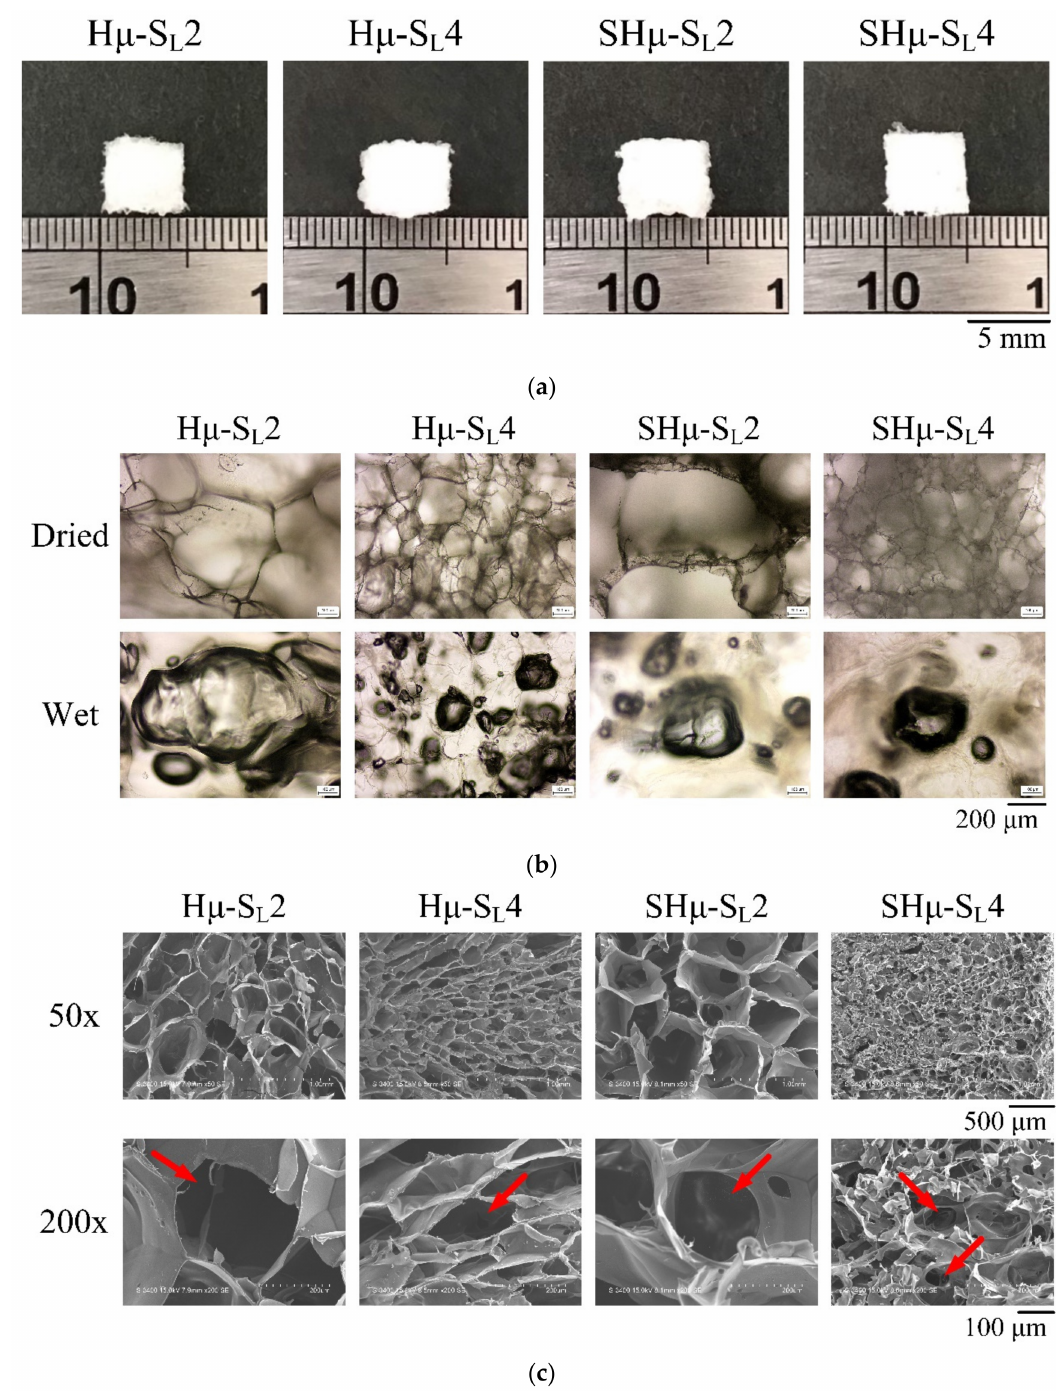
Figure 1. Hydrogel scaffolds are prepared by impregnating pore formers of different particle sizes and grams. ( a ) Light images, ( b ) OM, and ( c ) SEM analyses (the arrowheads show the perforation of the